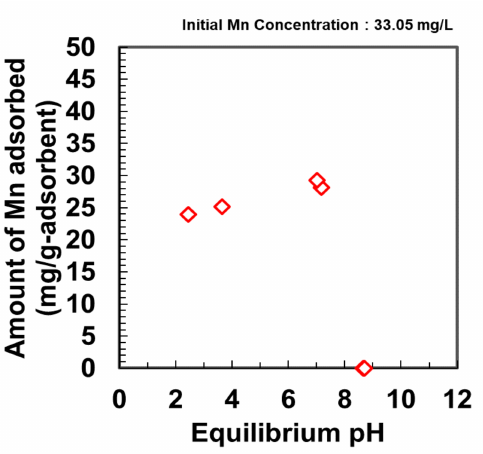
Figure 6. Effect of pH on the adsorption of Mn by DMAPAAQ + FeOOH